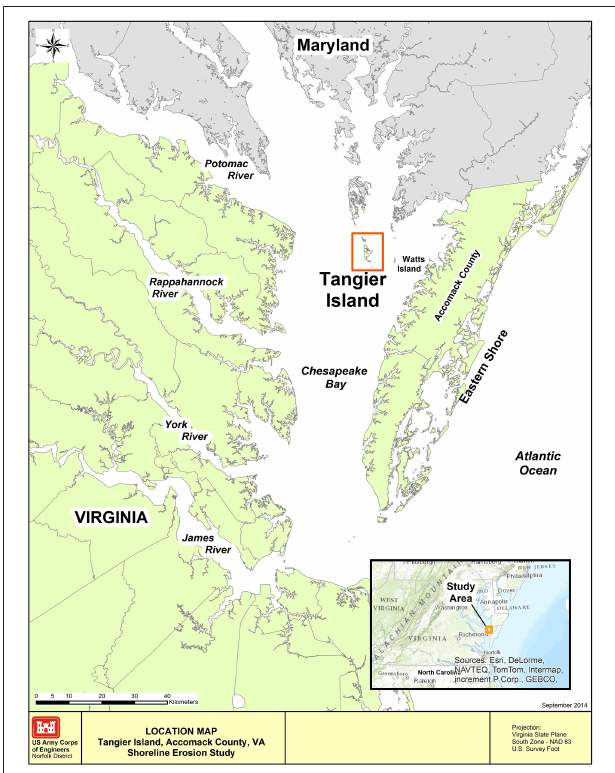
FIGURE 1 | Location and configuration of the Tangier Island and the Town of Tangier, in Virginia waters of Chesapeake Bay, USA. Source: Schulte et al. (2015) .